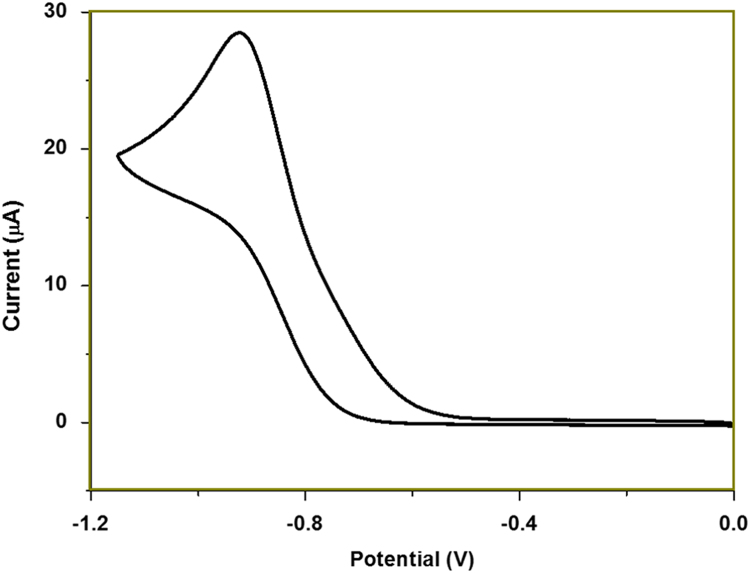
Cyclic voltammogram analysis of Azo–POP. (CH2Cl2. Scan rate 50 mV s−1).